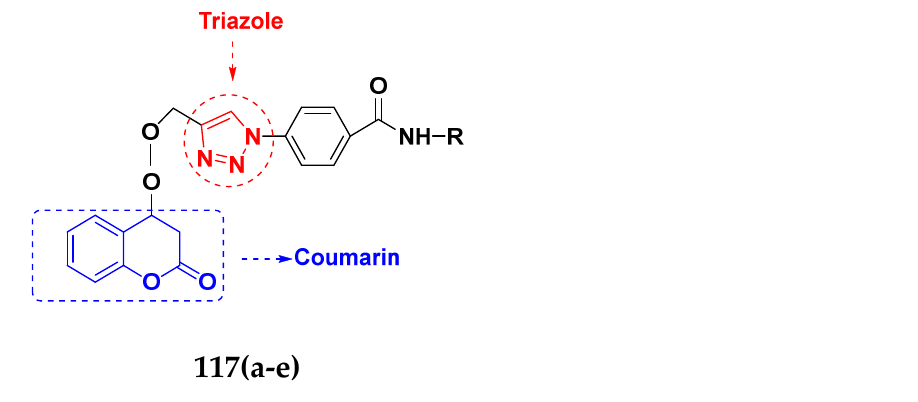
Figure 112. Structure of coumarin containing 1,2,3-triazole derivatives 117 ( a – e ). Table 99. In vitro cytotoxic activities of coumarin containing 1,2,3-triazole hybrid compounds 117 ( a – e ).